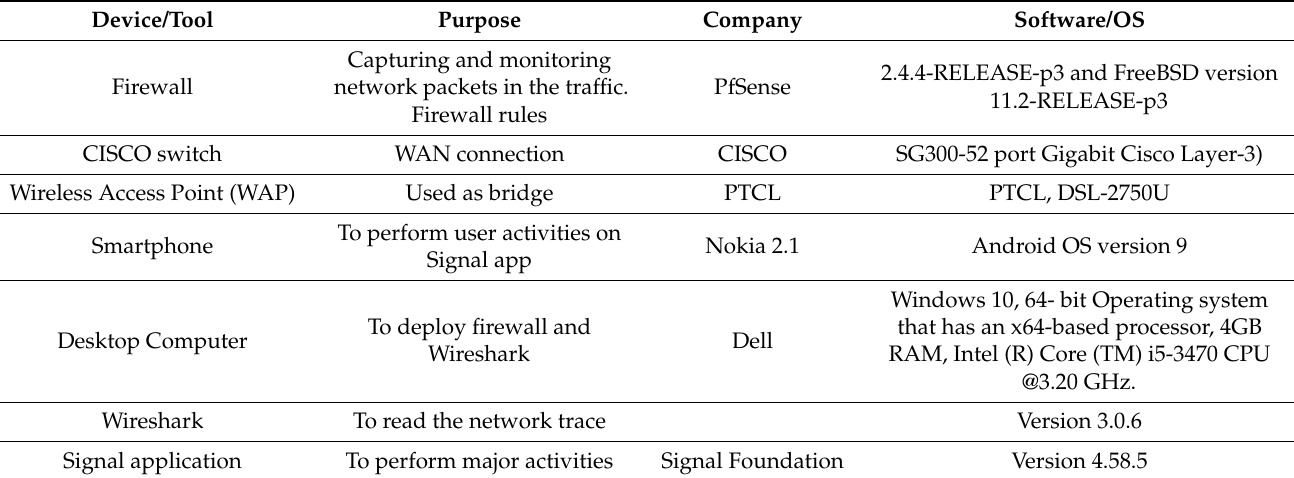
Table 2. Devices and tools specifications for experimental